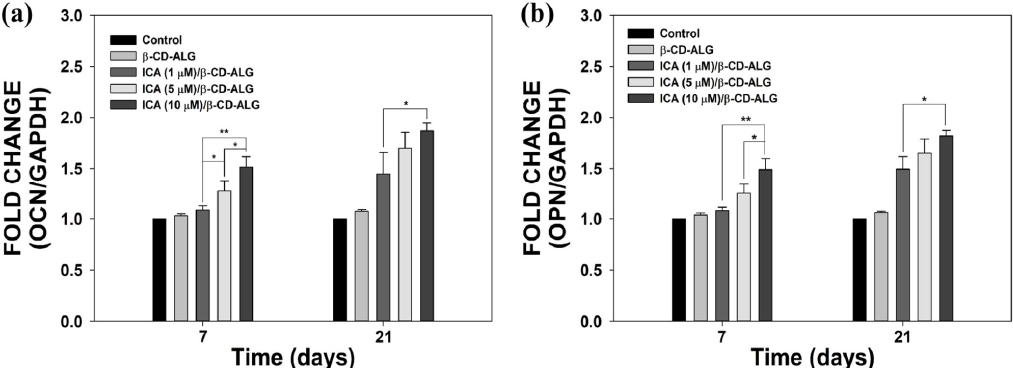
Figure 8. The gene levels of ( a ) OCN and ( b ) OPN in cells treated with β-CD-ALG, ICA (1  M)/β-CD- ALG, ICA (5  M)/β-CD-ALG, and ICA (10  M)/β-CD-ALG at 7 and 21 days (n = 4). ** P < 0.01 and * P <